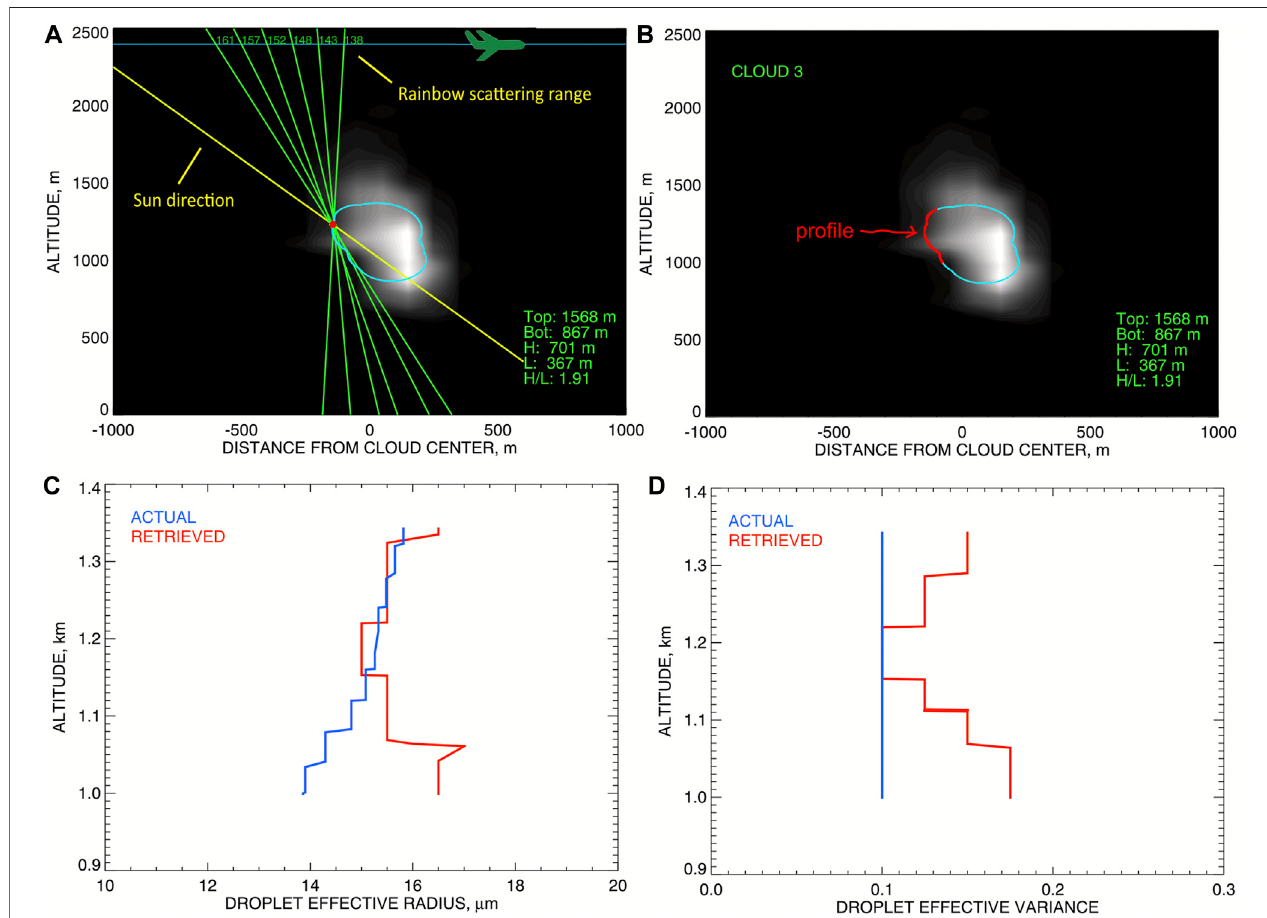
FIGURE 12 | Derivation of droplet effective radius and variance pro fi les from RSP polarized re fl ectances aggregated to points along the cloud ’ s side. The cloud shapehereistakenfrom Figure5B . (A) Schematicrepresentationofthemethodappliedtoasinglepointonthecloudsurface. (B) Thepartofthecloudsurfaceusedfor derivationofthepro fi les. (C) Thedropleteffectiveradiuspro fi les(blue — fromLESmicrophysics,red — retrievedfromtheRSPmeasurements). (D) Sameas (C) butforthe droplet effective variance.